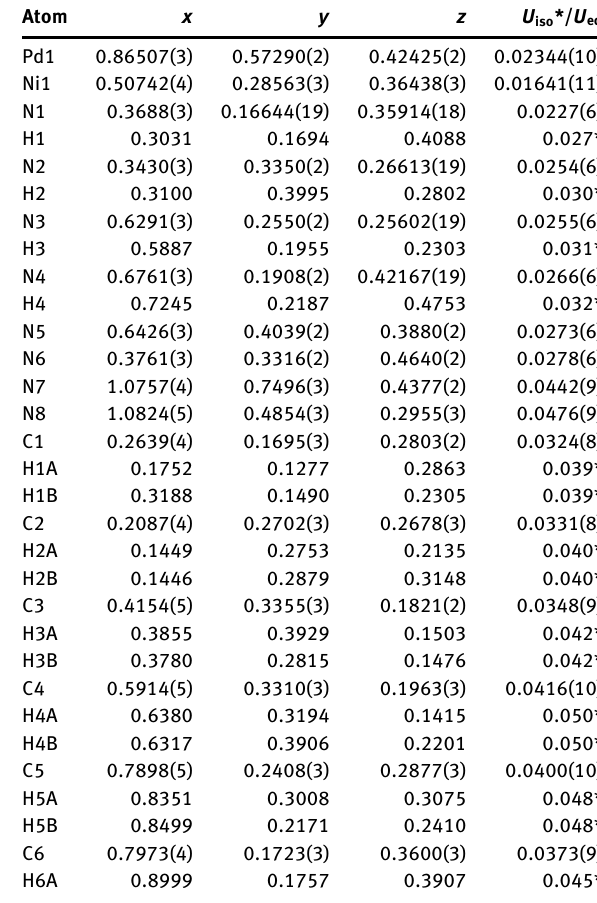
Table 2: Fractional atomic coordinates and isotropic or equivalent isotropic displacement parameters (Å 2